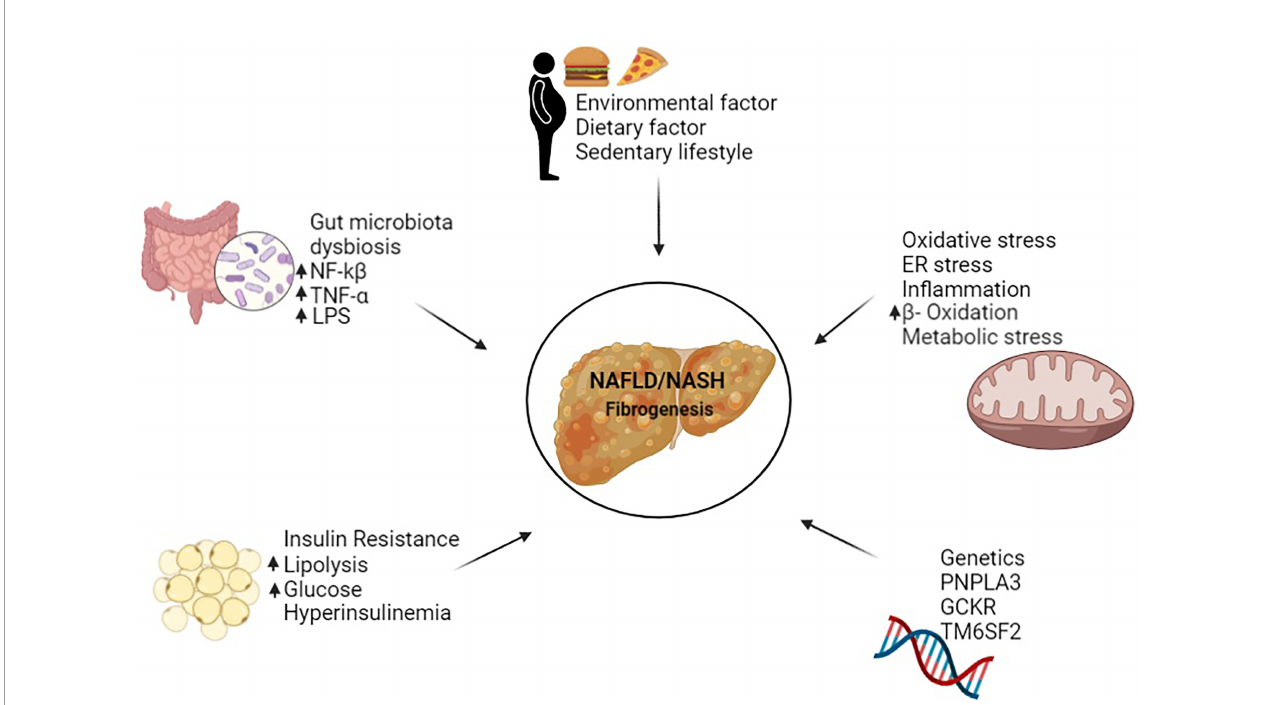
FIGURE 1 | Factors causing NAFLD/NASH in